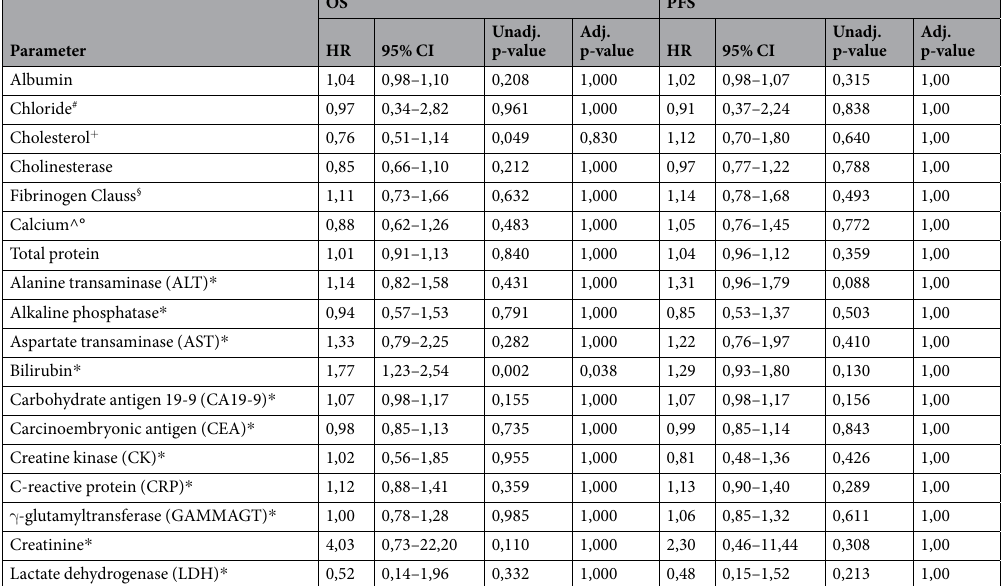
Table 2. Cox model analysis for biochemical parameters and OS and PFS. HR refers to the hazard ratio. 95% CI refers to 95% confidence interval. Unadj. = unadjusted, Adj. = adjusted. # HR refers to the effect of a 10 mmol/l